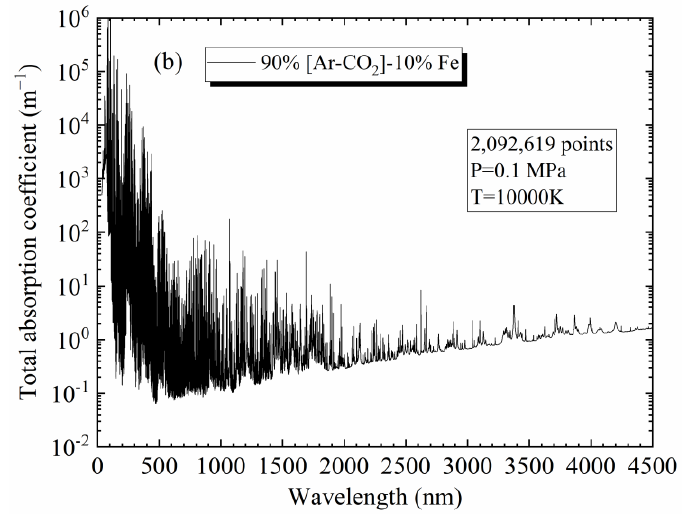
Figure 2. Total absorption coefficient at 0.1 MPa and 10,000 K for the thermal plasmas ( a ) 82%Ar- 18%CO 2 ; ( b ) 90%[82%Ar-18%CO 2 ]-10%Fe (molar proportions).